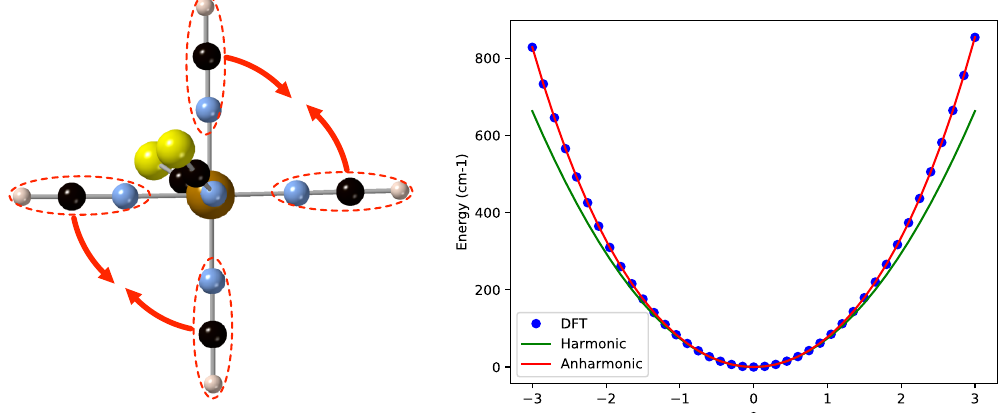
Figure 3. Left : In-plane NCH bending mode of the low-spin (LS) state of [Fe(NCS) 2 (NCH) 4 ]. Right : Comparison of the harmonic potential energy curve (in green) and the calculated energies (blue dots) fitted with a quartic expression (red